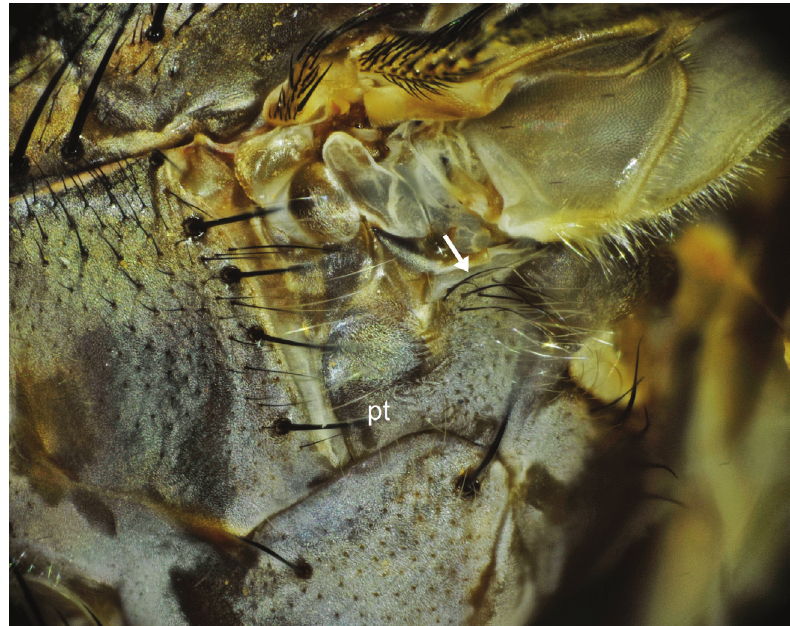
Figure 5. Pteropleuron (pt) of Bengalia varicolor (Fabricius), which is mostly clothed in yellow hairs, with a few black hairs present on upper part. Arrow shows the blackish